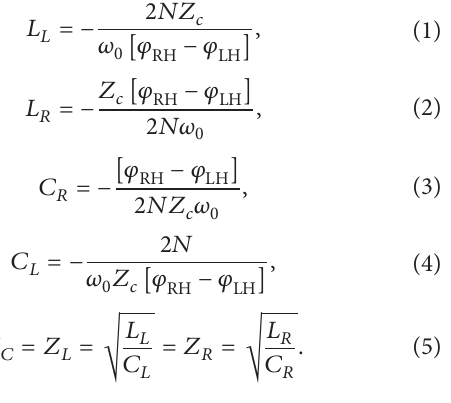
inductor performance; (d) full-wave simulation of the capacitor in HFSS; (e) electric capacitor 11 11